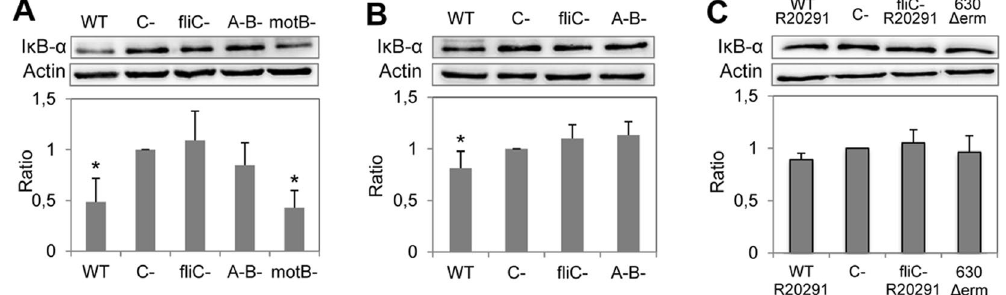
Figure 4. C. difficile flagella-induced degradation of I κ B- α . Caecal lysates were prepared as indicated in Material and Methods section and proteins were resolved by SDS-PAGE. ( A ) R20291 derivative-infected C57BL/6 mice; ( B ) 630 Δ erm derivative-infected C57BL/6 mice, and ( C ) R20291 derivative- or 630 Δ erm WT-infected C57BL/6 tlr5 − / − KO mice. Western blot were then performed using anti-I κ B- α , actin antibodies. Western blot cropped pictures (full-length blots are in the Supplementary Information file) show the results of a representative experiment. The density of the bands was measured using Fusion software. Ratios I κ B- α / actin were calculated and for the negative control (C-, uninfected mice), this ratio was normalized to 1. The ratio of the other samples was reported to the negative control. Results represent the mean (n = 10) ± standard deviations for each group of animals. * Statistically significant differences (P < 0.05) compared to the negative